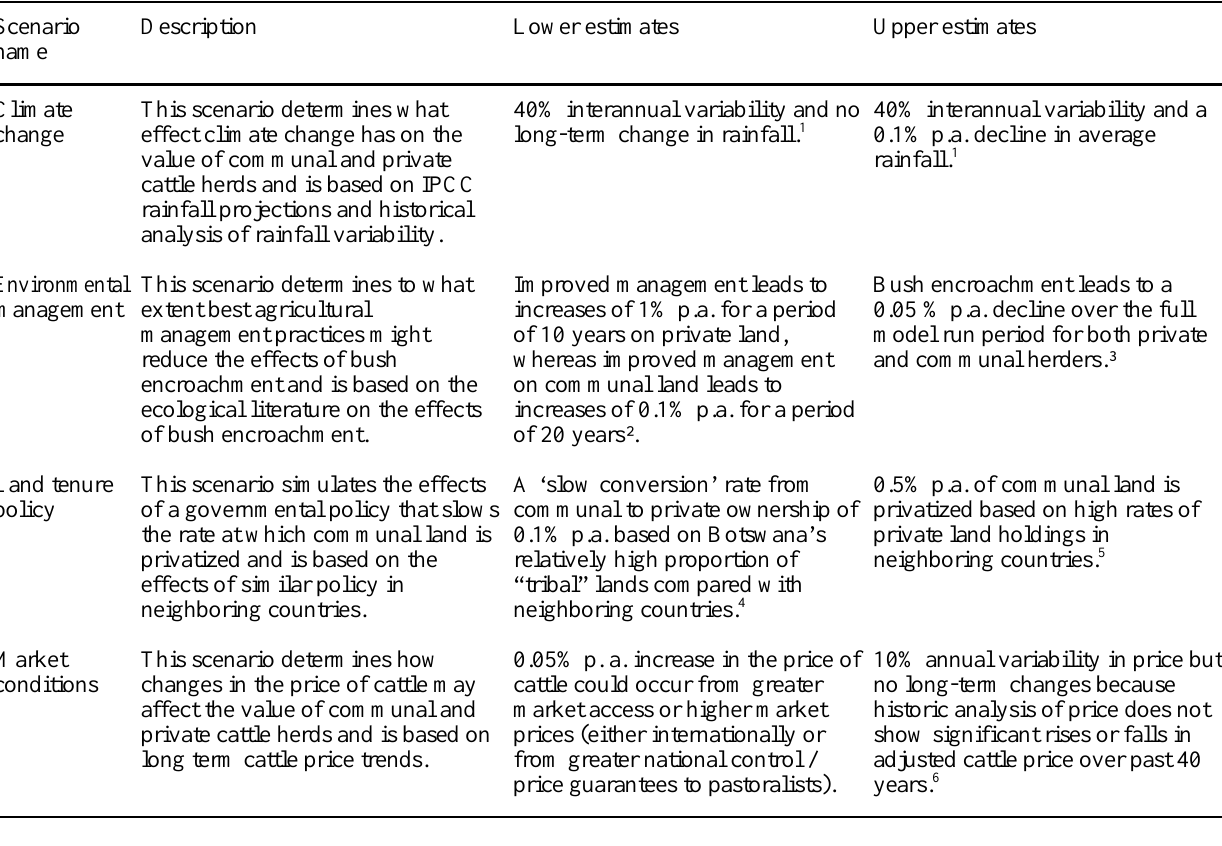
Table 1 . Summary of scenarios developed to quantify relative effect of different drivers on the value of cattle herd for private and communal herders in southern Botswana. The key references used to parameterize the scenarios are: (1) Christensen et al. 2007; (2) Quan et al. 1994, Reed and Dougill 2008; (3) Dougill et al. 1999 ; (4) Adams et al. 1999 ; (5) Adams 2001; (6) FAO 2006, Perrings and Stern